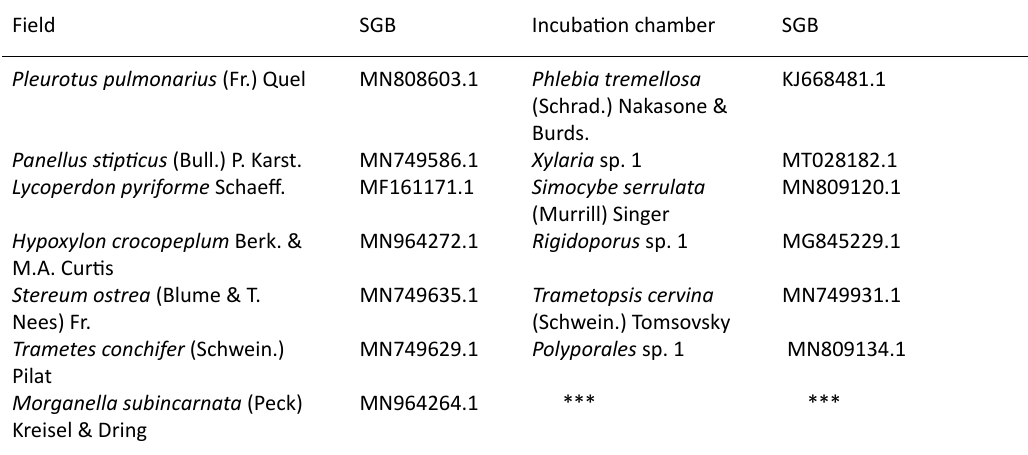
Table 2. Species of fungi recovered from the same substrates from the field and the incubation chambers Field SGB